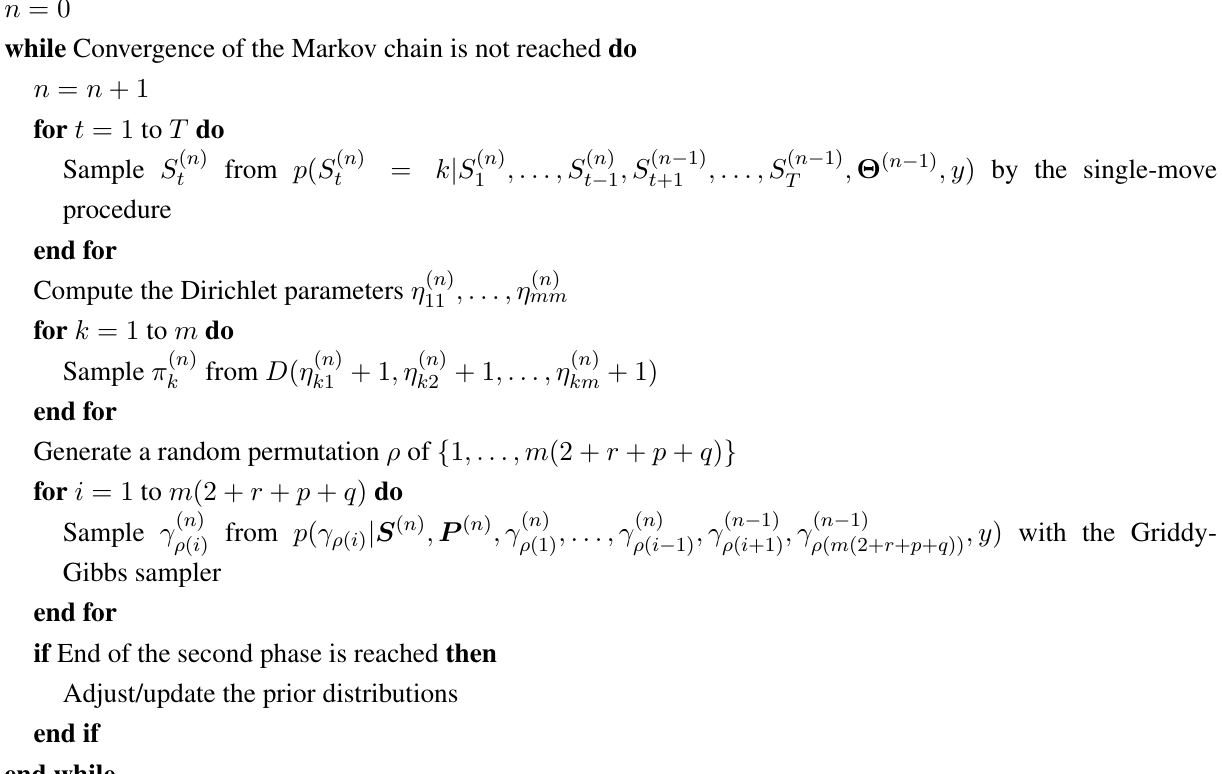
Algorithm 1 MCMC procedure for the estimation of MS-AR-GARCH